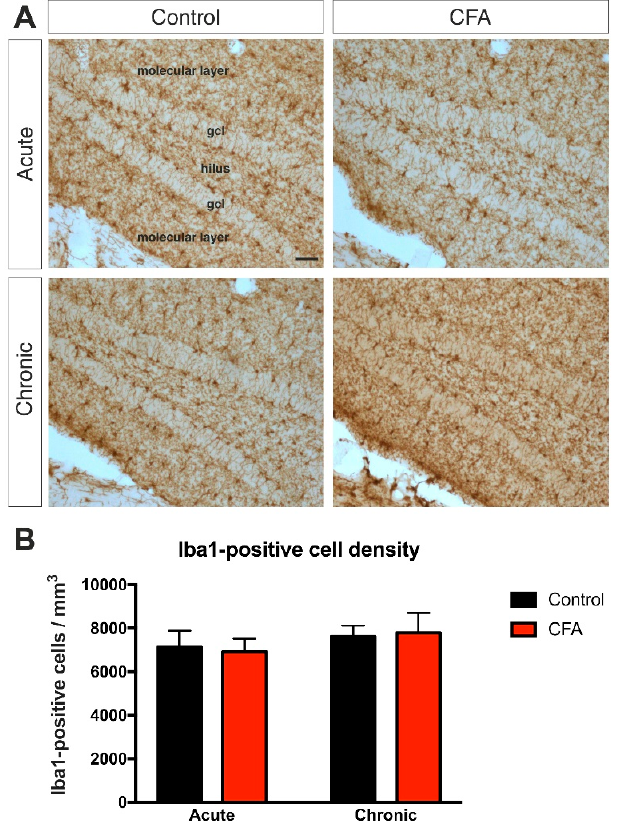
Figure 7. Inflammatory arthritis had no effect on the number of Iba1-immunopositive microglia in the dentate gyrus. ( A ) Representative images demonstrating Iba1-immunopositive microglia in the dentate gyrus of control and CFA-treated mice. Scale bar: 50 µm for all images. ( B ) Results of